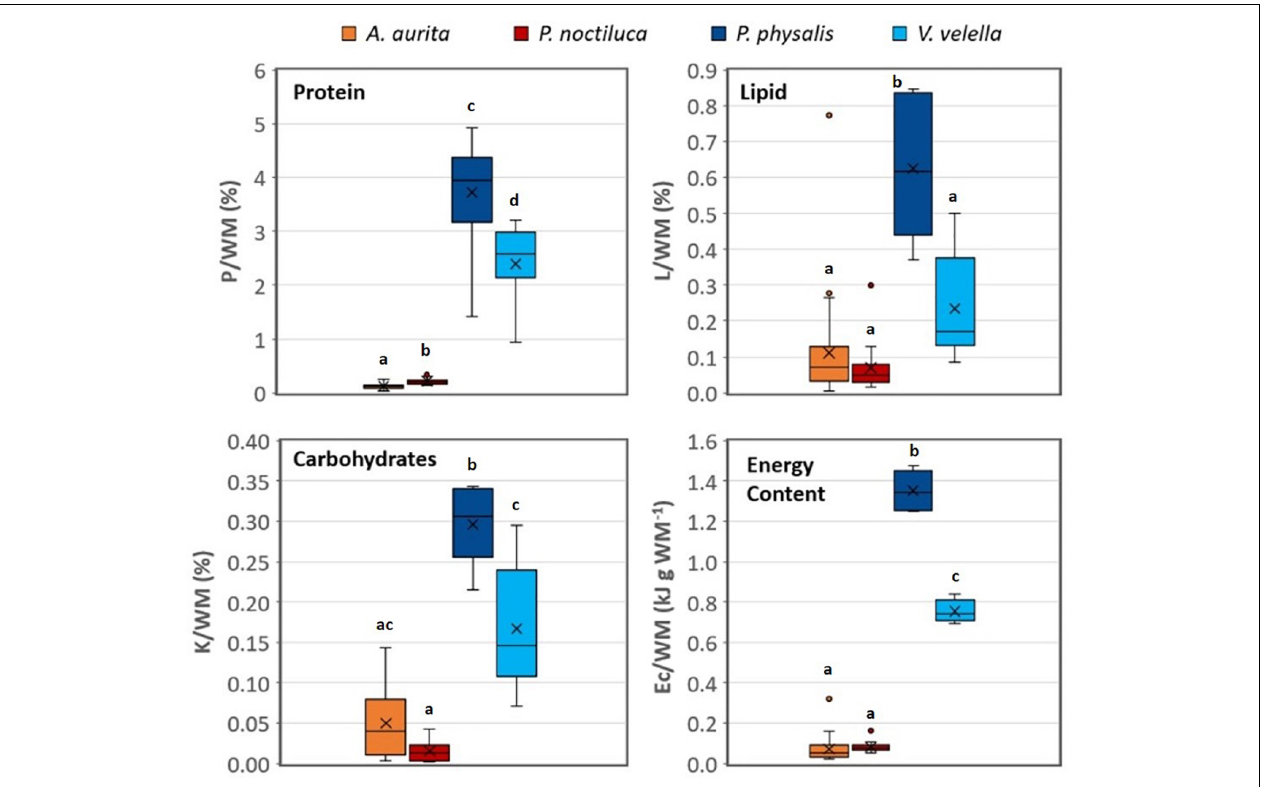
FIGURE 2 | Boxplots summarizing the protein (P), lipid (L), carbohydrate (K) and energy content (Ec) per wet mass (WM) in the four species. Small dots mark the outliers and “x,” the average. A. aurita , n = 38; P. noctiluca , n = 20; P. physalis , n = 17; V. velella , n = 11. A significant difference ( p < 0.05) in Games-Howell post hoc analysis represented with the letters “abcd.” If the boxplots share a letter, there was no significant difference found when their data was